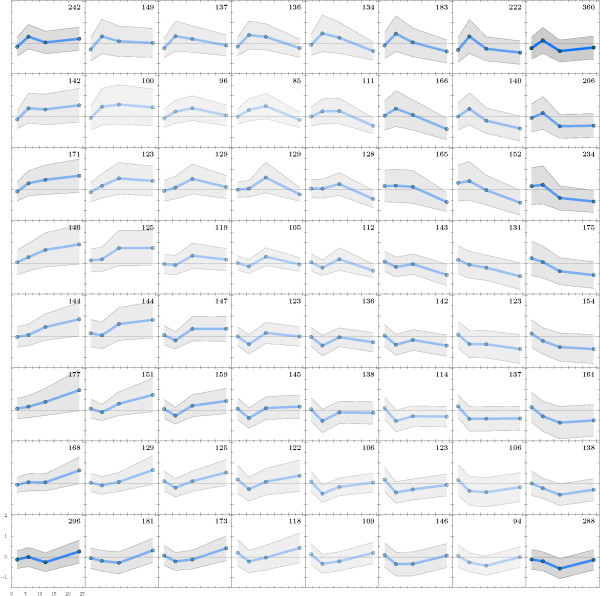
Self Organizing Map Analysis (SOMA) of 64 clusters of transcript abundance. This analysis shows 64 clusters of distinct patterns of transcript abundance. The highlighted square is significantly associated with ergosterol biosynthesis and TCA cycle transcripts. The transcript abundance data were clustered with a grid of size 10 × 10 (100 clusters) down to 3 × 3 (9 clusters) using the Pearson correlation coefficient as the metric between transcript profiles. The self-organizing map maximizing the number of clusters while limiting redundancies was the one of size 8 × 8 (64 clusters). Color intensity indicates the number of genes in each cluster.